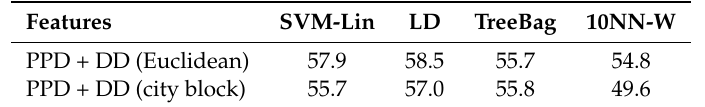
Table 3. Results of leave-one-subject-out, 5-fold cross-validation tests obtained for the Dataset 1.